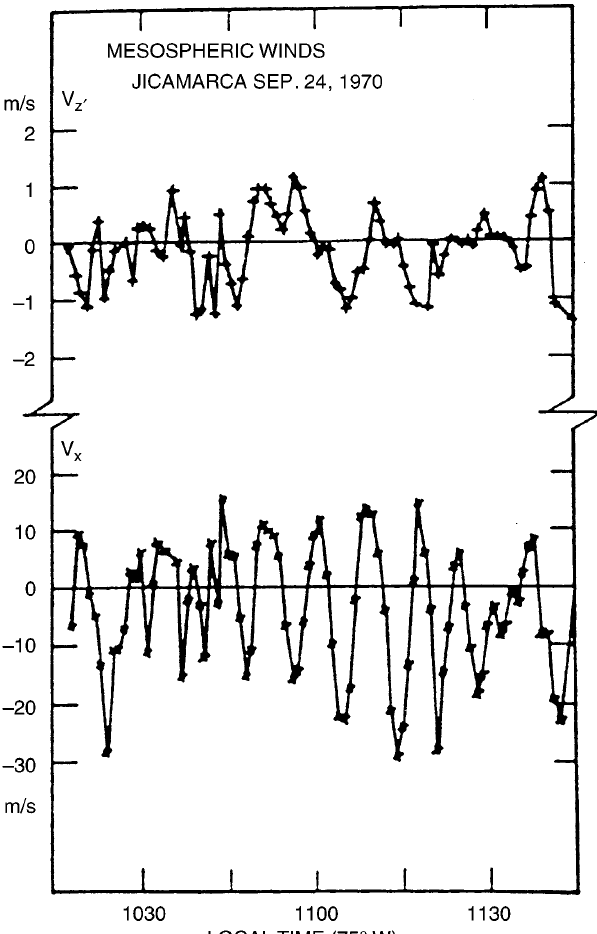
Fig. 2. Sample time series of vertical ( top ) and zonal ( bottom ) wind speeds at 85 km in the mesosphere showing large sinusoidal fluctuations due to gravity wave (from Woodman and Guille´